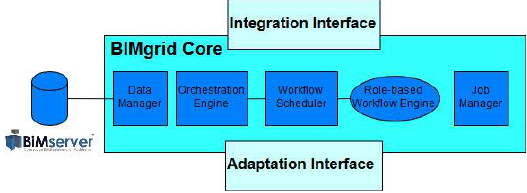
Figure 3. BIMgrid interface architecture (Polter and Scherer,